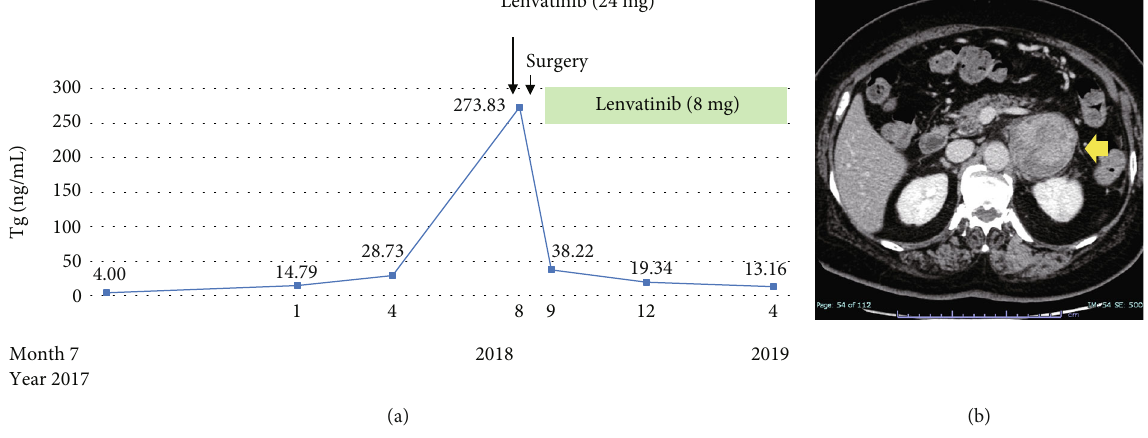
Figure 3: Clinical course of the patient. (a) Serum thyroglobulin level (T) rapidly increased in step with the size of the left adrenal tumor. We initiated 24 mg lenvatinib treatment, but due to uncontrollable intratumoral bleeding, the patient had to undergo surgery. The serum thyroglobulin level immediately decreased after surgery, and the patient was again treated with lenvatinib, now at only 8 mg. (b) Computed tomography fi ndings of intratumoral bleeding of the left adrenal tumor